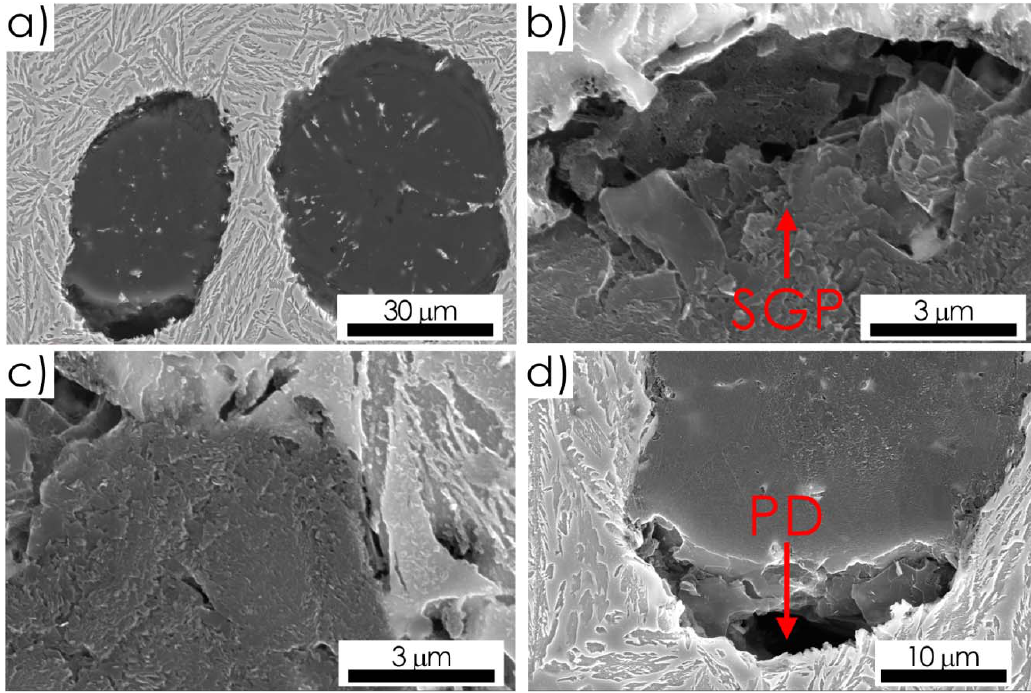
Figure 15. Graphite nodules in a microregion near fracture area in the ADI390 specimen, SEM: ( a ) Effects of the local G ‐ M debonding ( b ) the local debonding on top pole of a graphite spheroid visible shifted graphene plates (SGP), ( c ) matrix particles embedded in the external rim, ( d ) local complete pole G ‐ M debonding (PD) on bottom pole of spheroid, visible shifted graphene plates (SGP).